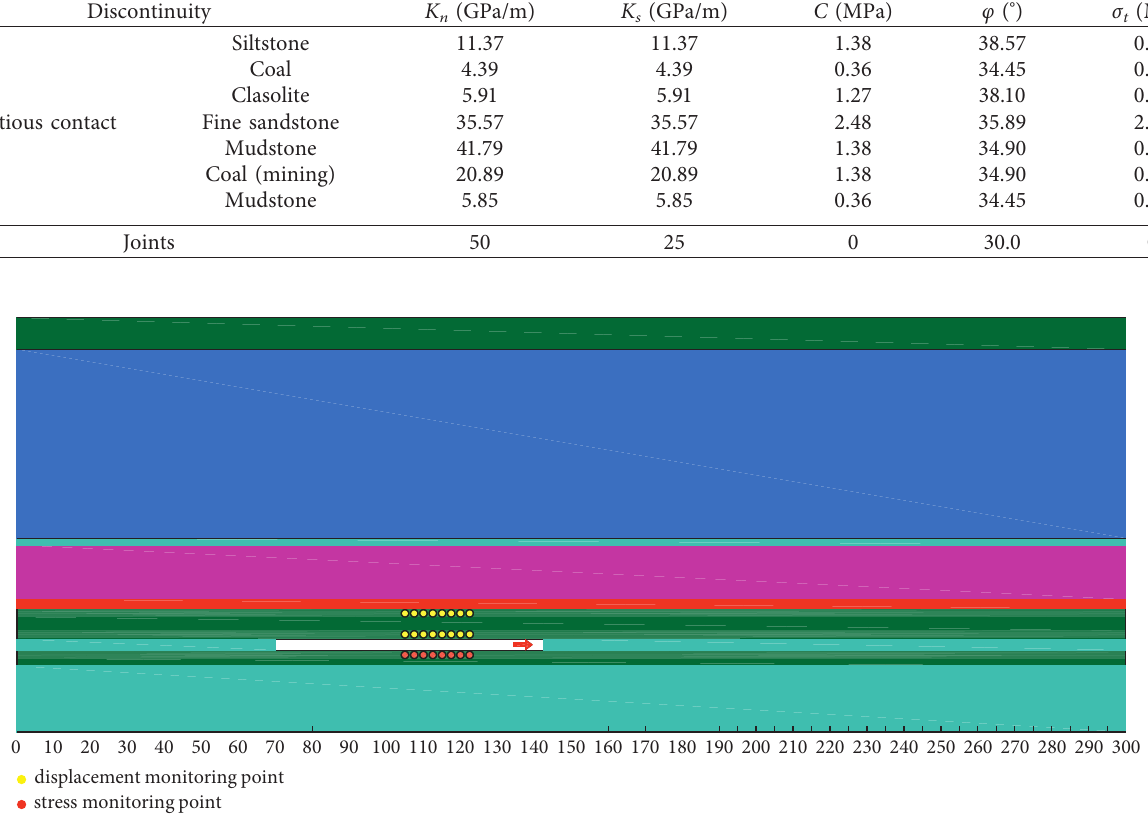
Figure 4: Arrangement of monitoring